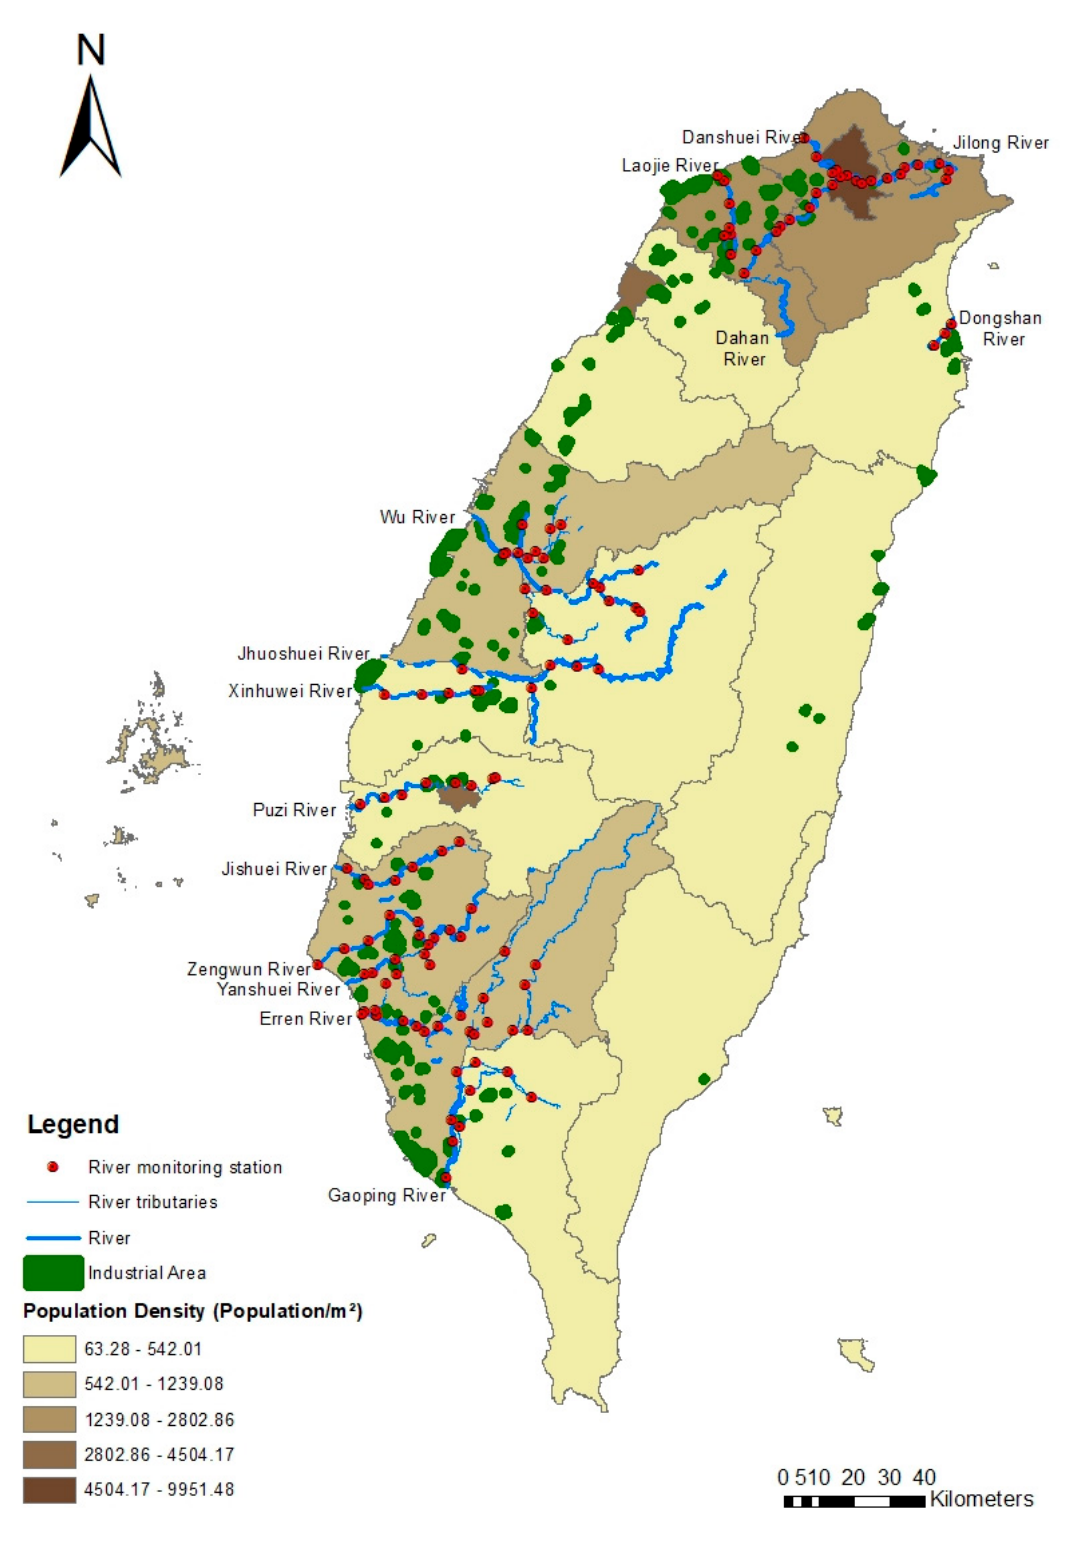
Figure 2. Study area of 14 Taiwan representative rivers and their sampling points, population density, and industrial area map.